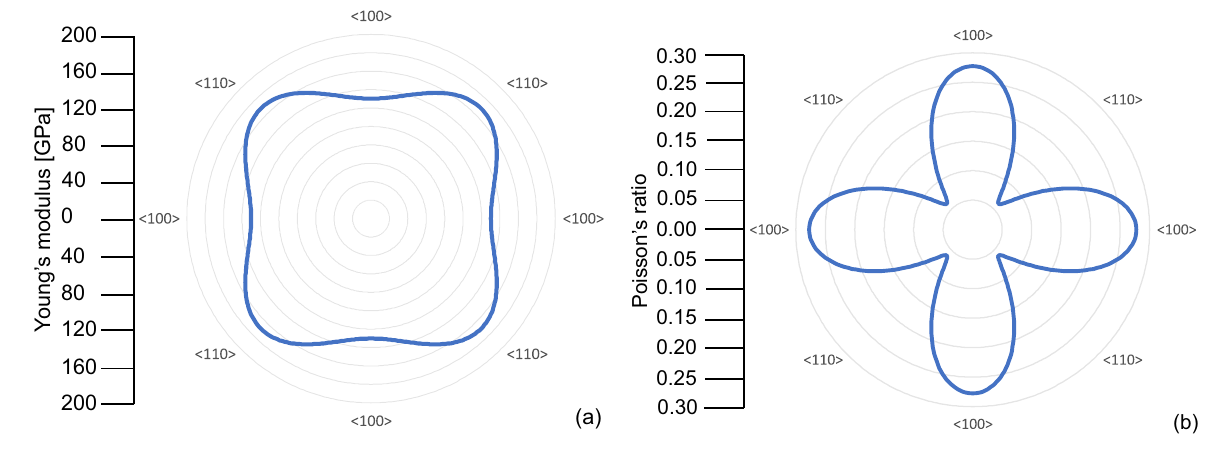
Figure 5. Si(100) anisotropy (a) Young’s modulus (b) Poisson’s ratio.